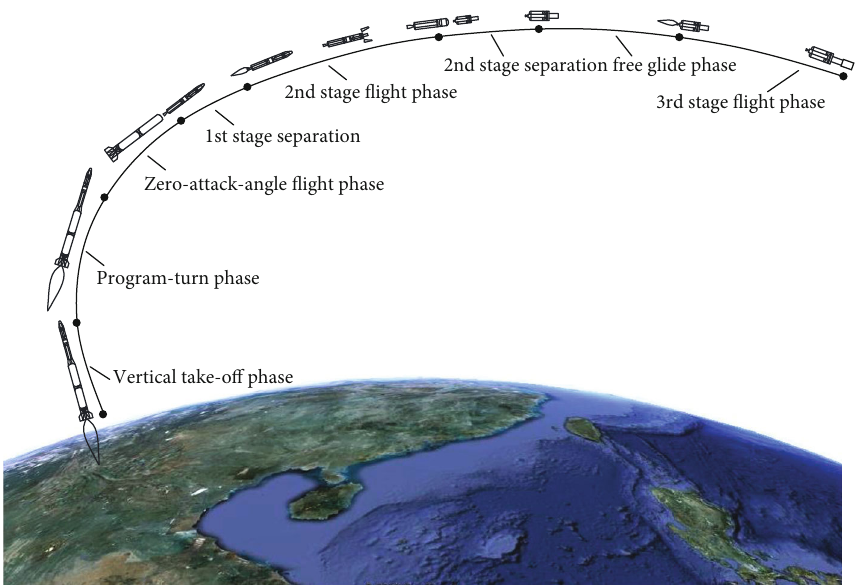
Figure 9: Schematic diagram of the fl ight process.